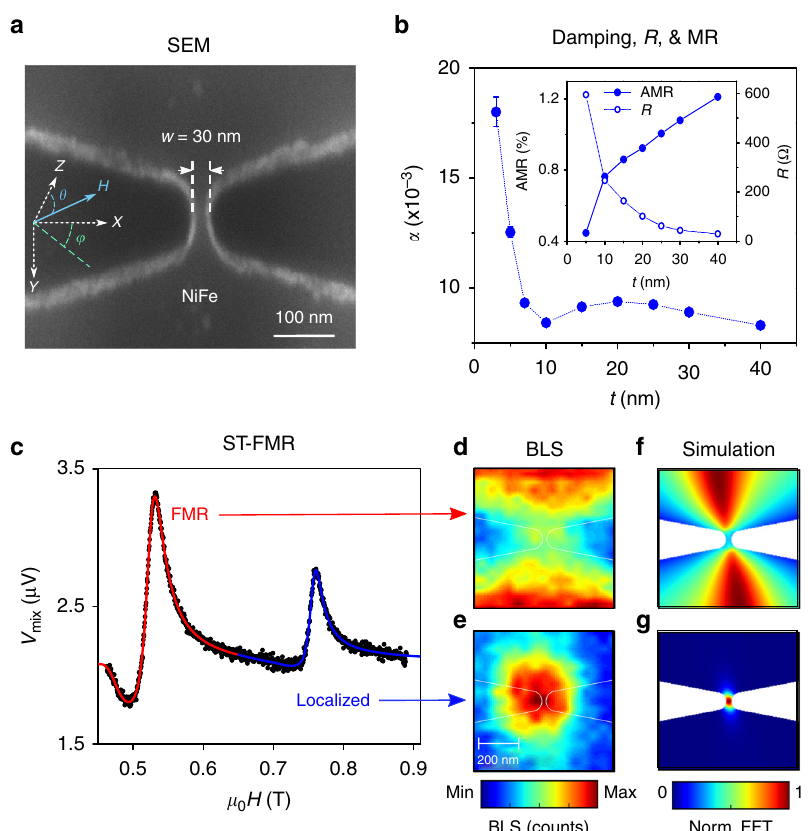
Fig. 1 Nano-constriction fabrication, characterization, and simulation. a Scanning electron microscope image of a permalloy nano-constriction showing its width ( w = 30 nm) and the direction of the applied fi eld. b Gilbert damping of blanket permalloy fi lms as a function of fi lm thickness. Inset: AMR (closed symbol) and resistance (open symbol) vs. thickness of 30 nm wide nano-constrictions. c ST-FMR spectrum vs. fi eld at f = 10 GHz for a w = 30 nm and t = 15 nm nano-constriction showing its two linear modes; red and blue lines are Lorentzian fi ts to the FMR mode and the localized mode, respectively. The spatial distribution of the FMR and the localized modes, imaged by μ -BLS ( d , e ), and calculated using micromagnetic simulations ( f , g We categorize the measured PSD into two regions depending on the strength of the magnetic fi eld: region (I) for low fi elds | H | ≤ 0.3 T and region (II) for high fi elds | H | > 0.3 T. In region (I) the PSD is independent of the fi eld-current symmetry, i.e., a measurable PSD is always present regardless of the fi eld and current polarities. The microwave signal in this region is rather weak with a large linewidth. In region (II) the auto-oscillations are both sharper and more powerful and are detected only when the orientation of the fi eld and current satisfy H · I > 0. In this region, the spin current creates a spin-torque that is aligned either anti-parallel ( H · I > 0) or parallel ( H · I < 0) to the damping and hence it either suppresses or enhances the damping depending on symmetry. The spectral characteristics of the auto-oscillations are measured with a linewidth of 100 MHz and an integrated power of 2 pW.